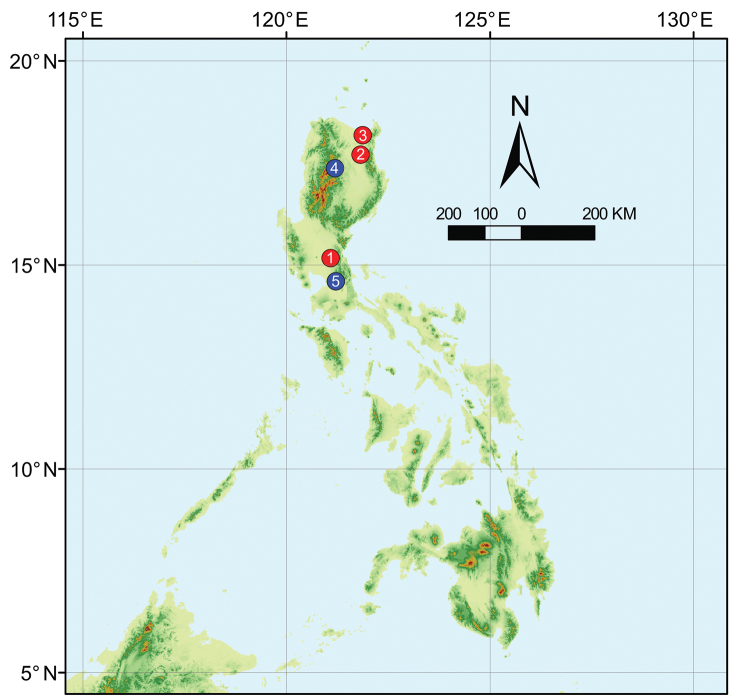
Distribution of five Luzonacera in Philippines 1Luzonacerafrancescoballarini sp. n. 2L.lattuensis sp. n. 3L.peterjaegeri sp. n. 4L.duan5L.chang.